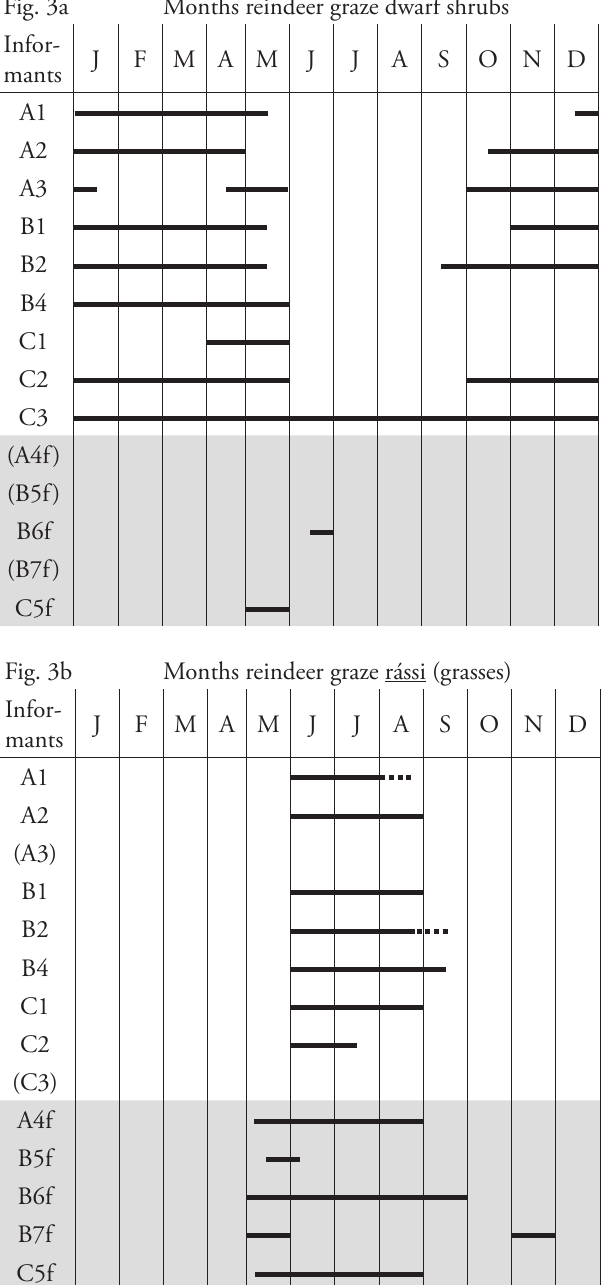
Months reindeer graze rássi